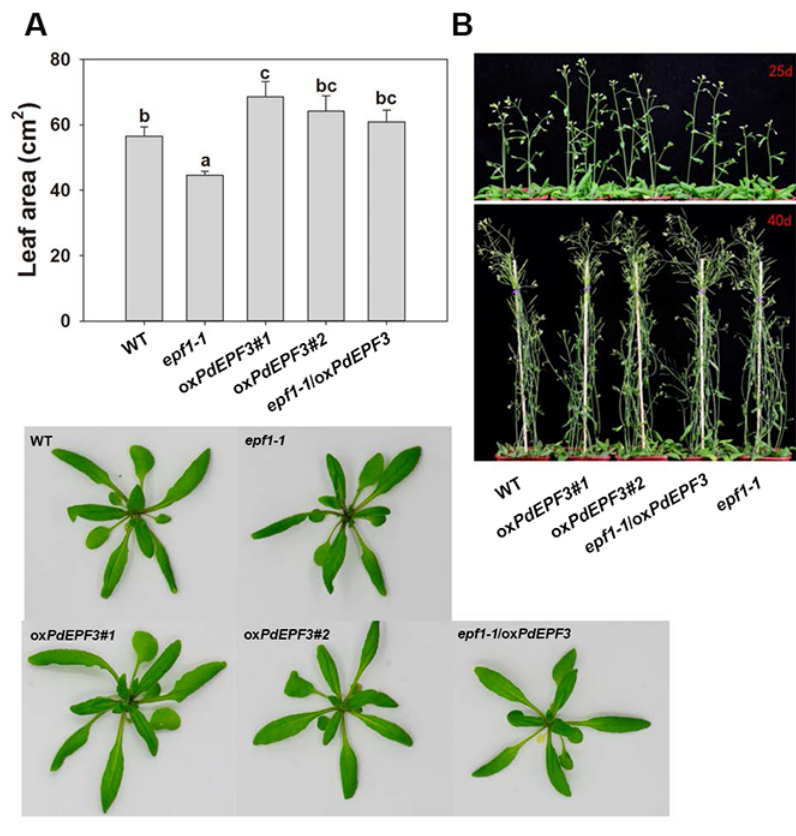
Fig. 3 Morphological analysis under well-watered condition. ( A ) Difference in rosette leaf area of 22-day-old seedlings. ( B ) Morphology of 25-day-old and 40-day-old seedlings grown under well-watered condition. Data represent means ± SE ( n = 3). Different letters indicate significant difference ( p <